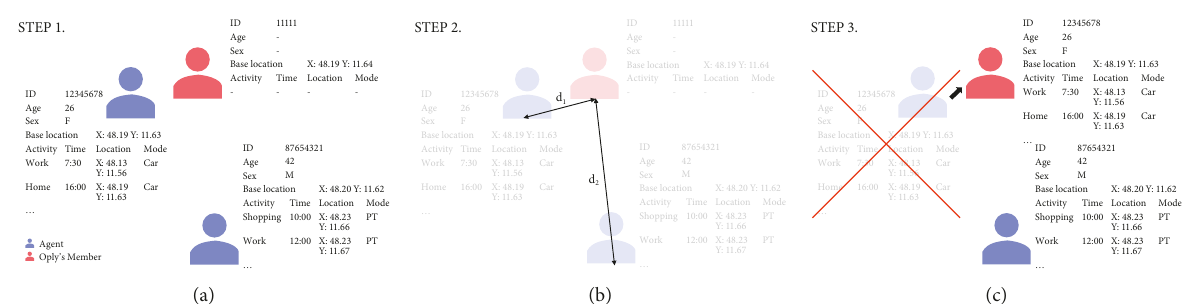
Figure 3: Example of the Iterative Linking Algorithm. (a) The agents, with their relative geographic coordinates and any attributes, are imported into the GIS software. (b) ILA searches for the agent n closest (in terms of Euclidean distance) to member m. (c) ILA assigns the attributes of agent n to member m then deletes agent n so that its attributes are not assigned to a possible member m + i